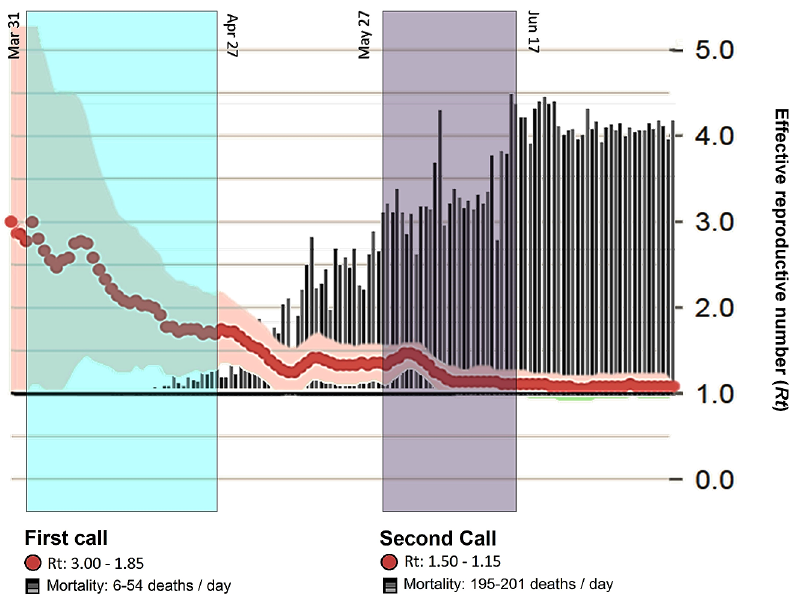
Figure 1. Peruvian research calls during the pandemic. Development of calls for research projects according to the trend line of cases (R, red line), mortality rate (black and white bars) and period of time of the